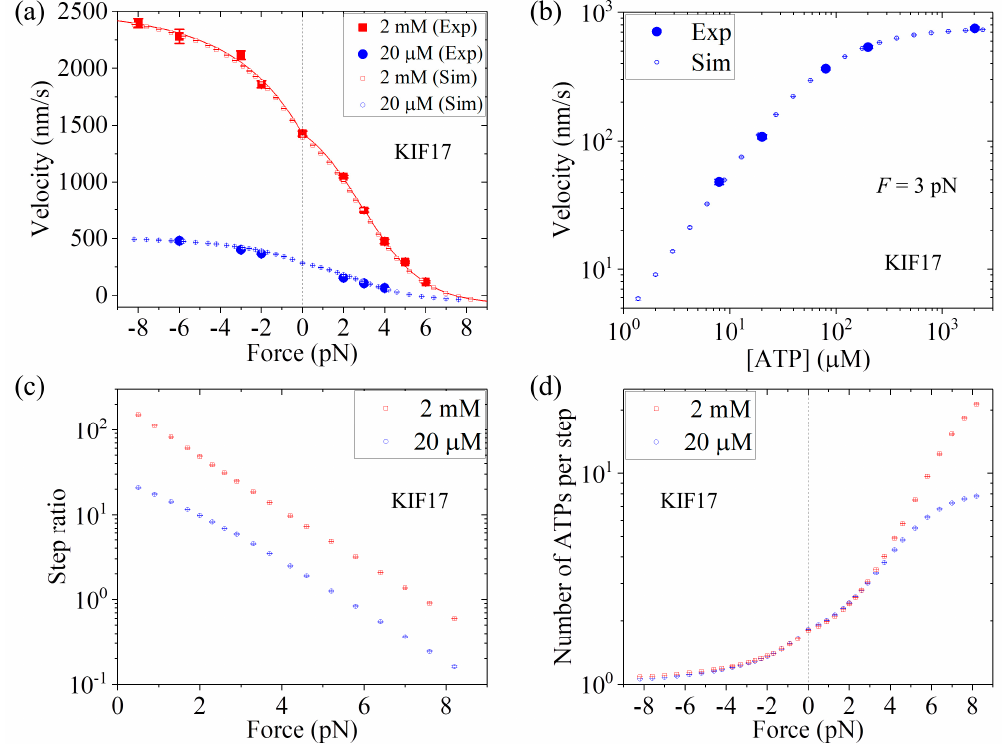
Figure 8. Dynamics of KIF17 at different ATP concentrations. Unfilled symbols are MC simulated data, with error bars representing SEM ( n = 1000), line is the analytical solution at saturating ATP, and filled symbols are experimental data taken from Milic et al. [25]. ( a ) Velocity versus external force. ( b ) Velocity versus ATP concentration under backward force of 3 pN. ( c ) Stepping ratio versus external force. ( d ) Number of ATP molecules consumed per step versus external force.